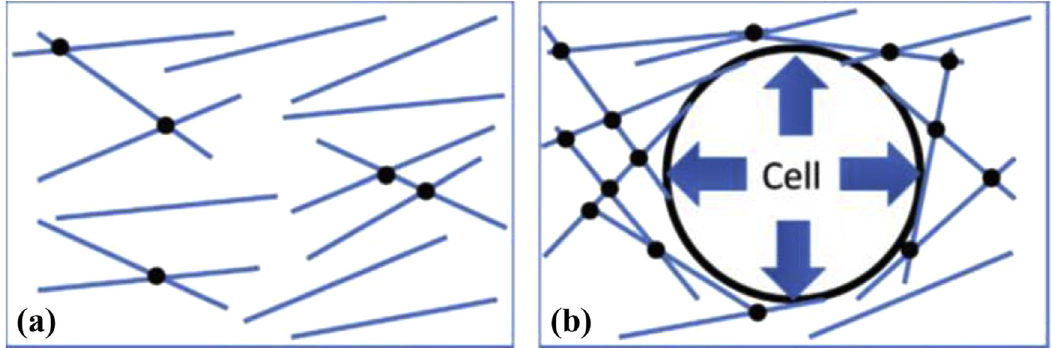
Figure 3: Schematic illustration of the e ff ect of cellular air porosity on the interconnectivity of fi bers. Fiber alignment ( a ) before and ( b ) after cell formation [ 62 ]